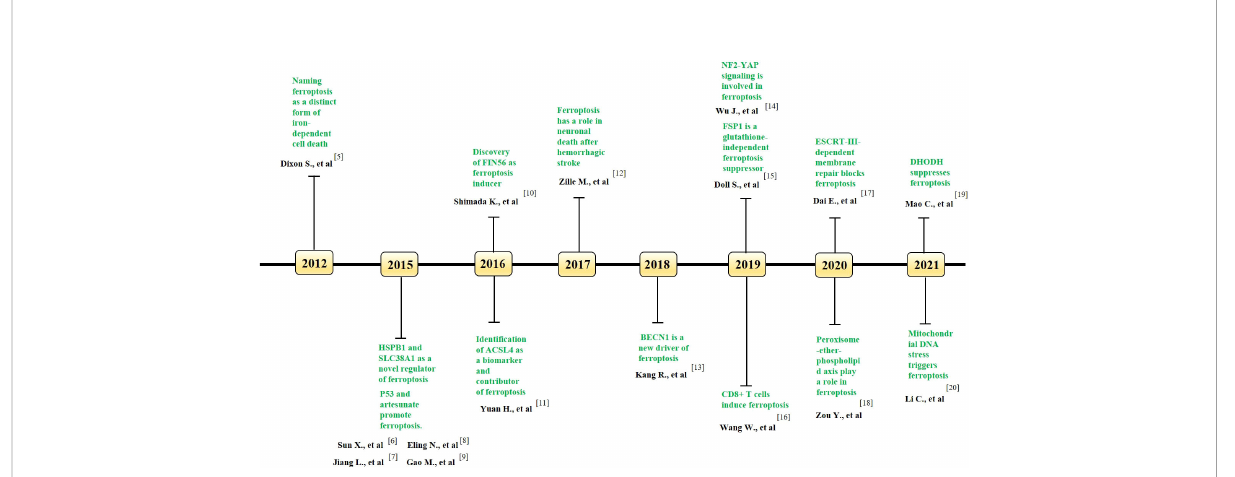
FIGURE 1 Key milestones in the literature of ferroptosis over time. The key discoveries related to ferroptosis in each year is indicated. GPX4, Glutathione peroxidase 4; HSPB1, heat shock protein beta-1; SLC38A1, solute carrier family 38 member 1; FIN56, Ferroptosis inducing 56; ACSL4, acyl- coenzyme A synthetase long-chain family member 4; BECN1, beclin 1; NF2, neuro fi bromin 2; YAP, Yes-associated protein; FSP1, ferroptosis suppressor protein 1; ESCRT, endosomal sorting complexes required for transport; DHODH, dihydroorotate